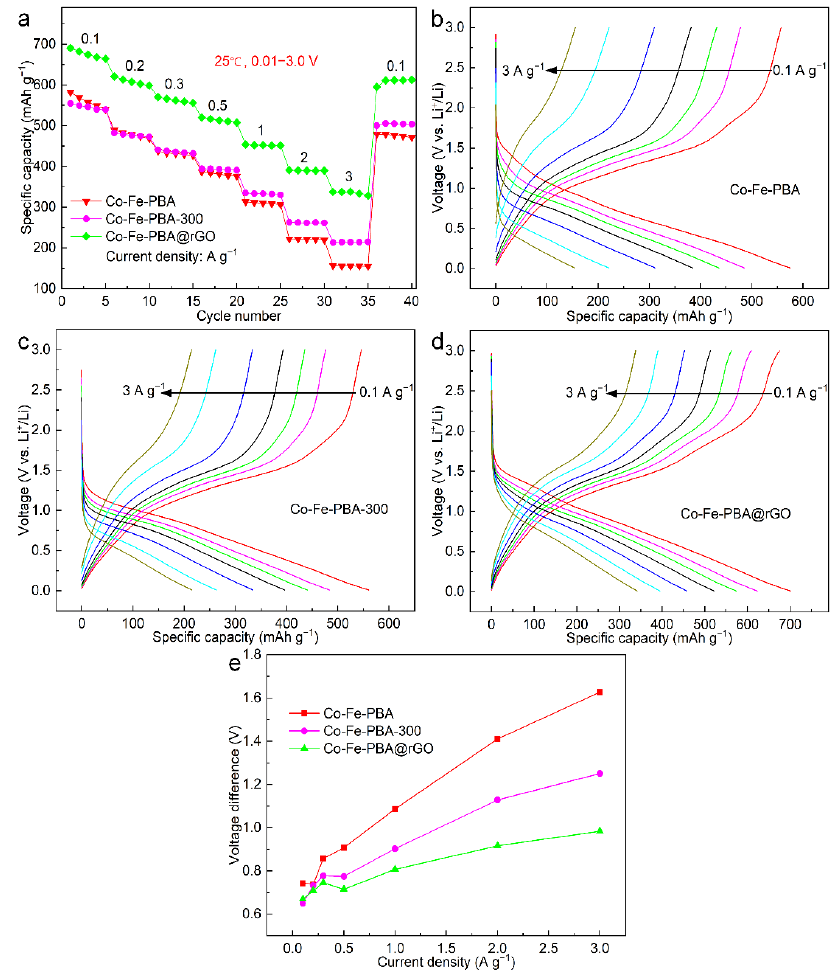
Figure 5. ( a ) Rate capabilities of Co-Fe-PBA and Co-Fe-PBA-300, together with